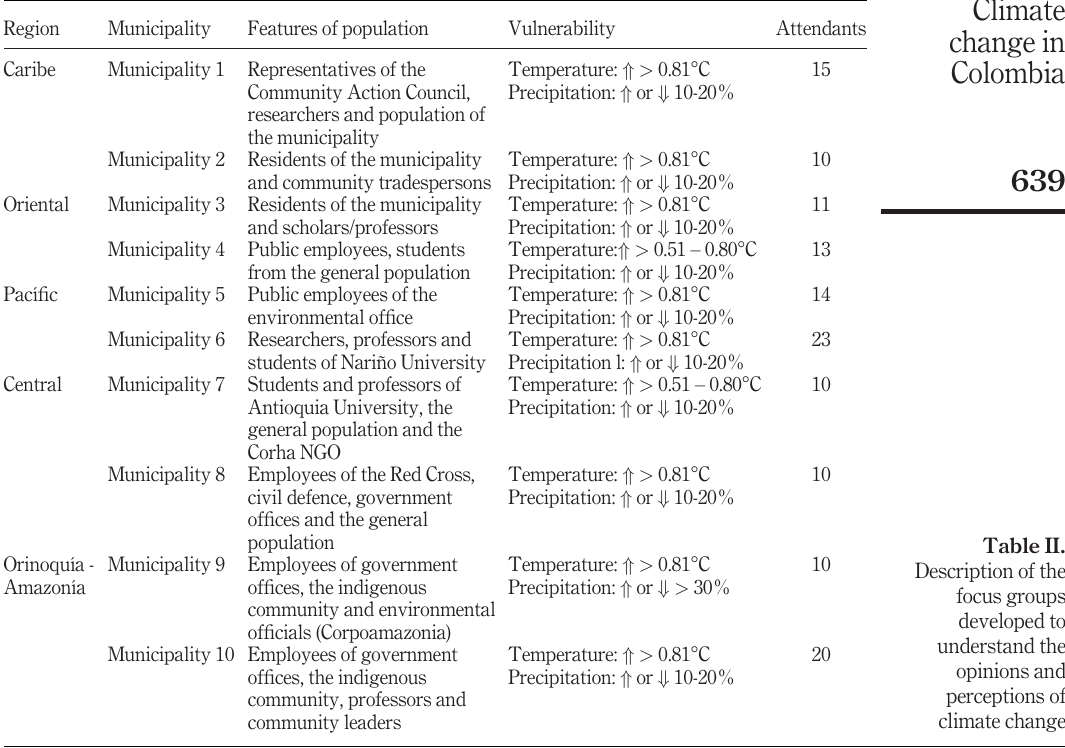
Table II. Description of the focus groups developed